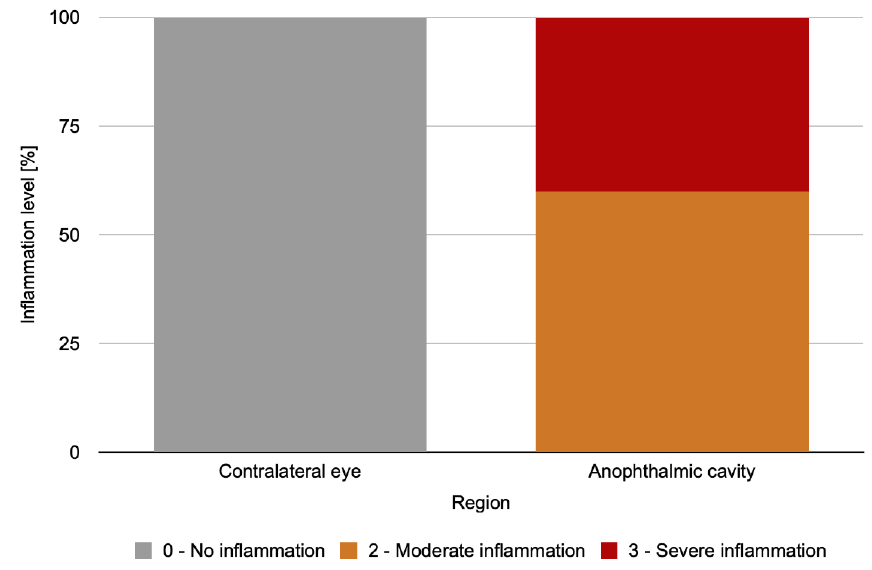
Figure 4. Percentage distribution of the level of palpebral conjunctiva inflammation in the initial period in the different regions analyzed in the IG.